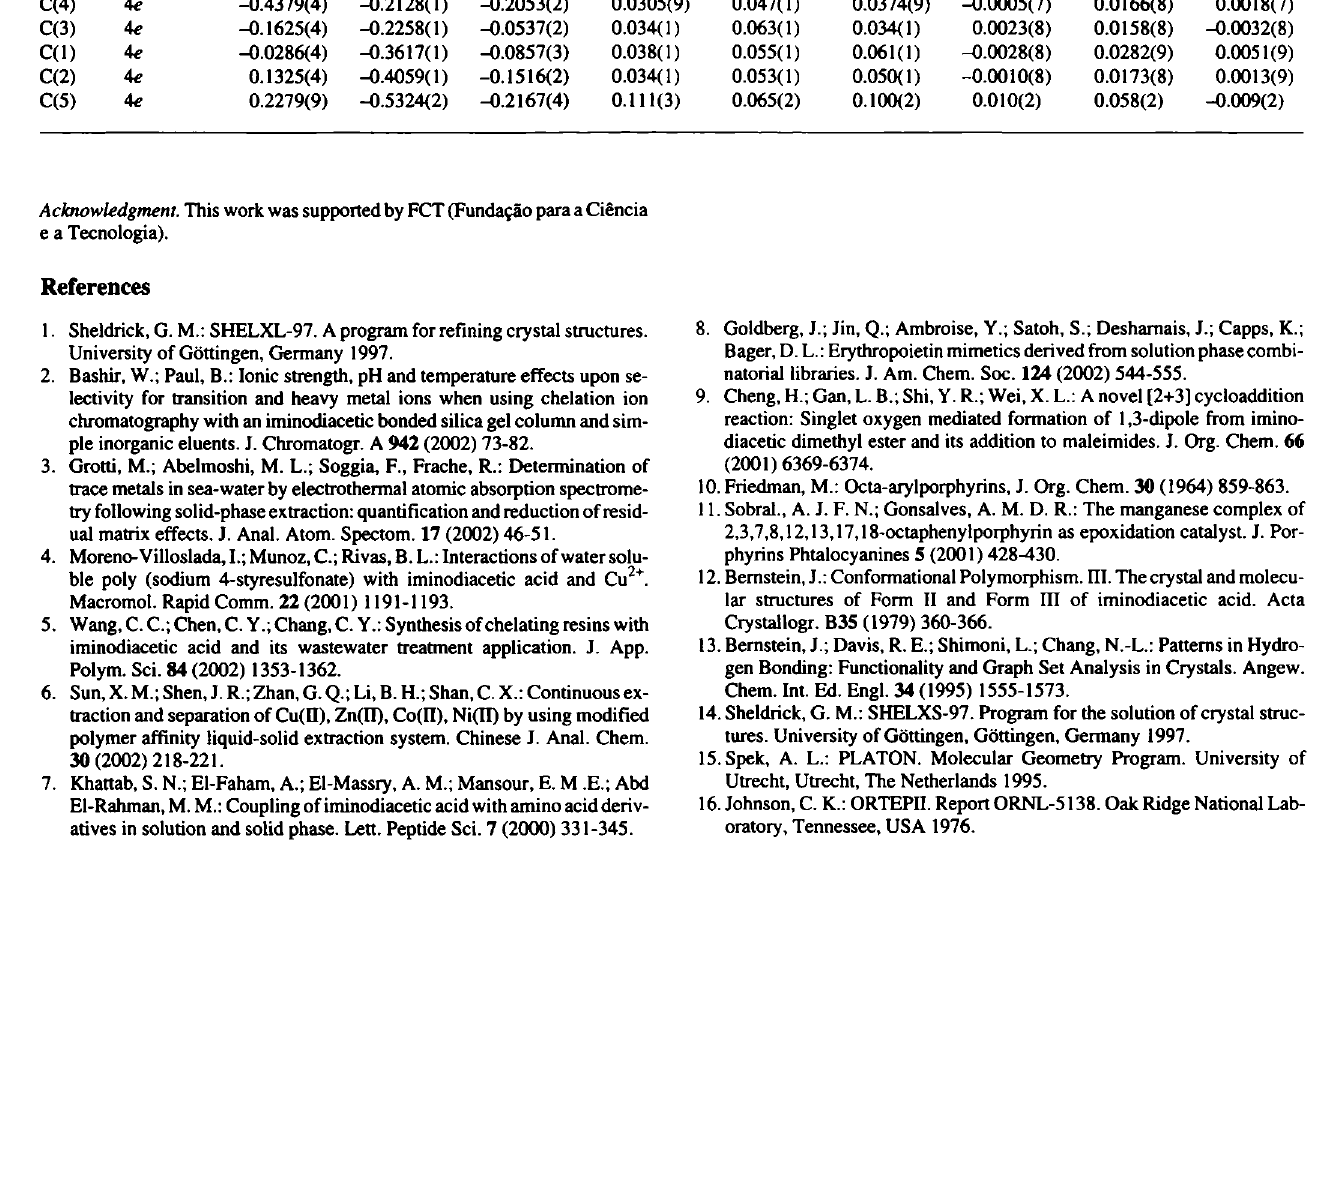
Table 3. Atomic coordinates and displacement parameters (in Â 2